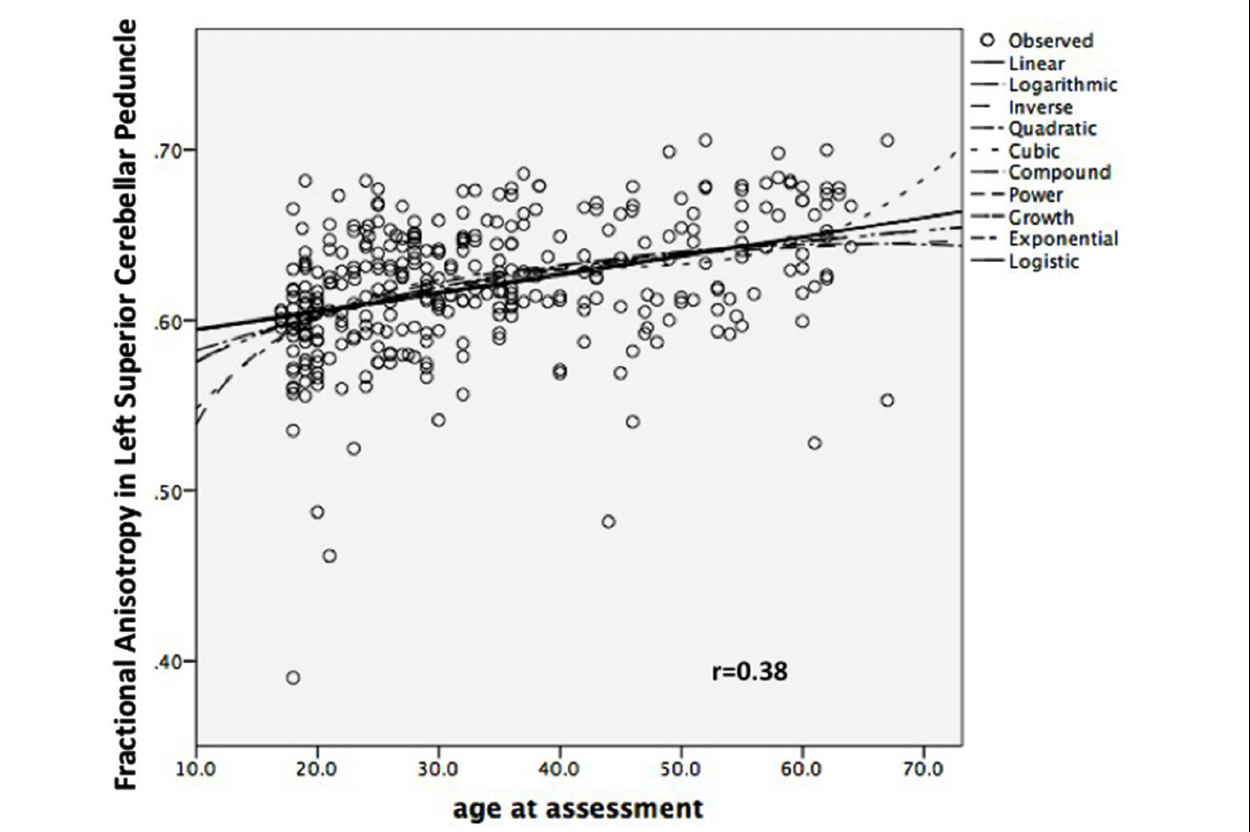
FIGURE 2 | Scatterplot of Left Superior Cerebellar Peduncle Fractional Anisotropy against Age, combined sample ( n =